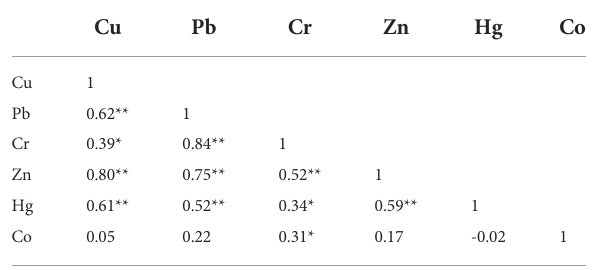
TABLE 4 Pearson correlation coef fi cient of heavy metals in mangrove sediments.